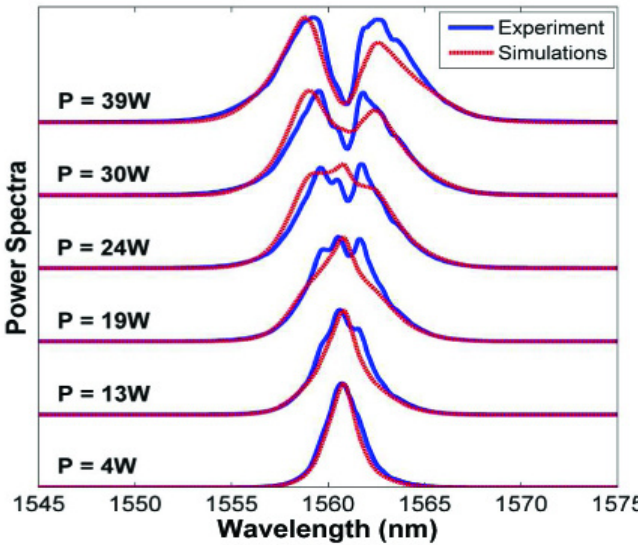
Figure 8. Efficient self-phase modulation, using ~1 ps pulses near 1560 nm, was achieved in low loss (<0.06 dB/cm) and 45 cm long spiral integrated waveguide of high-index silica glass [49]. In this figure, experimentally measured output power spectra (solid blue lines) and theory (dashed red lines) for different input (coupled) power levels are reported. Reprinted with permission from [52] © The Optical Society.